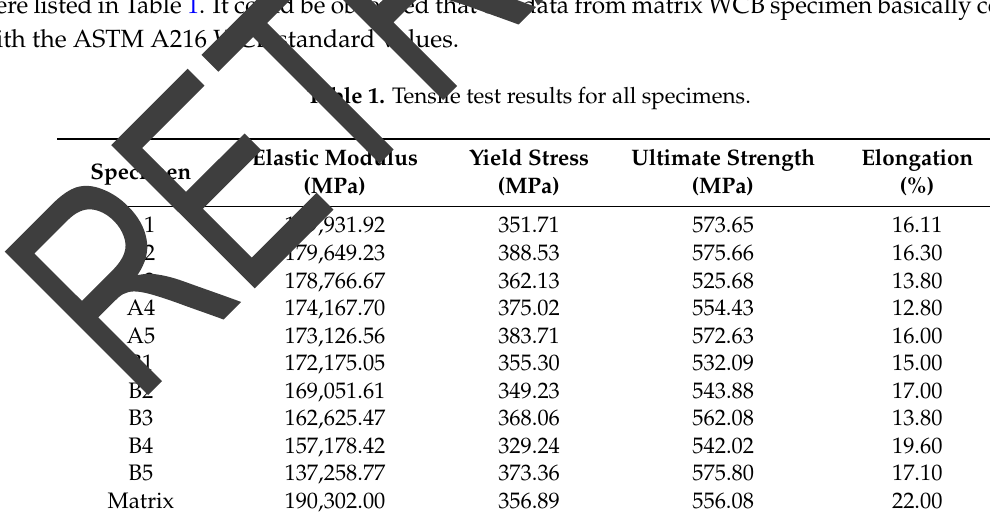
Table 1. Tensile test results for all